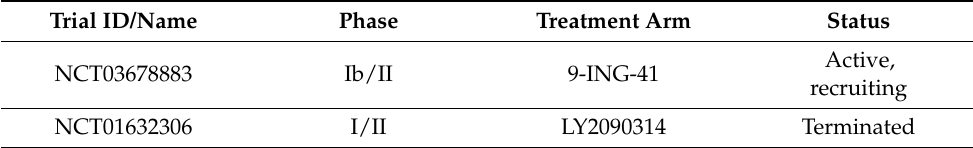
Table 1. Ongoing Trials Evaluating GSK-3 β Inhibitors in Pancreatic